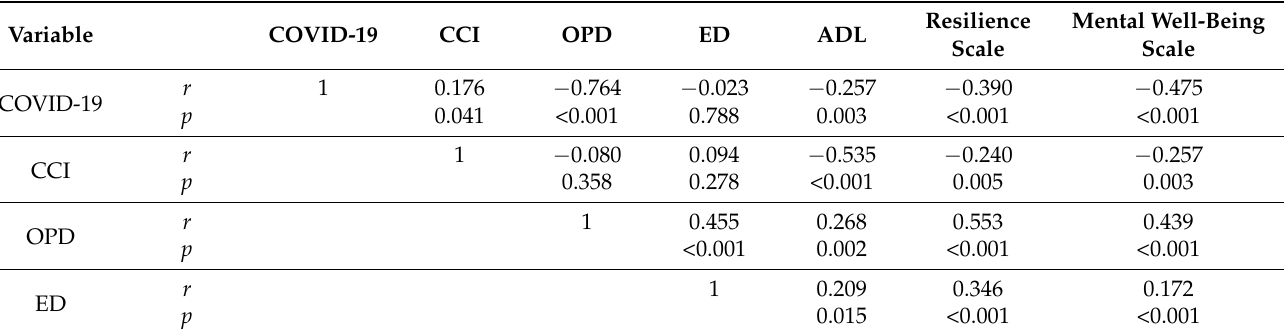
Table 3. Variable correlations.